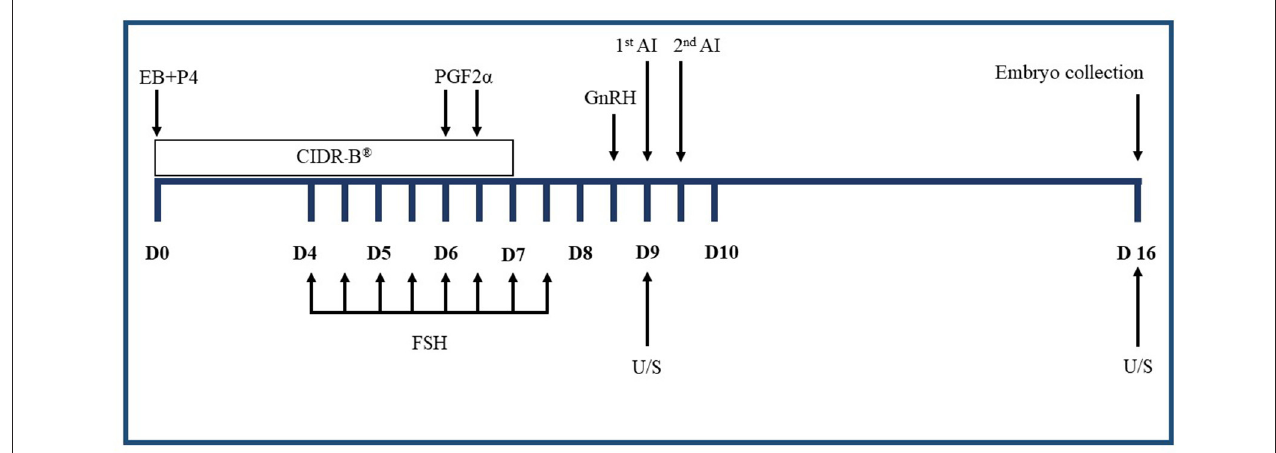
FIGURE 1 | Superovulation treatments in the experiment. CIDR-B ® , intravaginal device impregnated with 1.56g progesterone; EB, estradiol-17 β ; P4, progesterone; FSH, follicle-stimulating hormone in eight decreasing doses; PGF 2 α , prostaglandin F2 α ; GnRH, gonadotrophin-releasing hormone; 1 st AI, the first